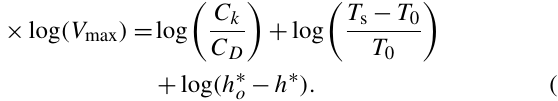
Figure 8. Skew-T log-P thermodynamic diagram with isotherms (thin black curves), dry adiabats (green curves), and moist adiabats (blue curves). The bold black line is a mean environmental temper- ature profile from the North Atlantic main development region, the magenta curve is the moist adiabat associated with a mean North At- lantic sea-surface temperature (SST), and the red curve is the moist adiabat associated with a sea-surface temperature 3 ◦ C warmer than the mean.